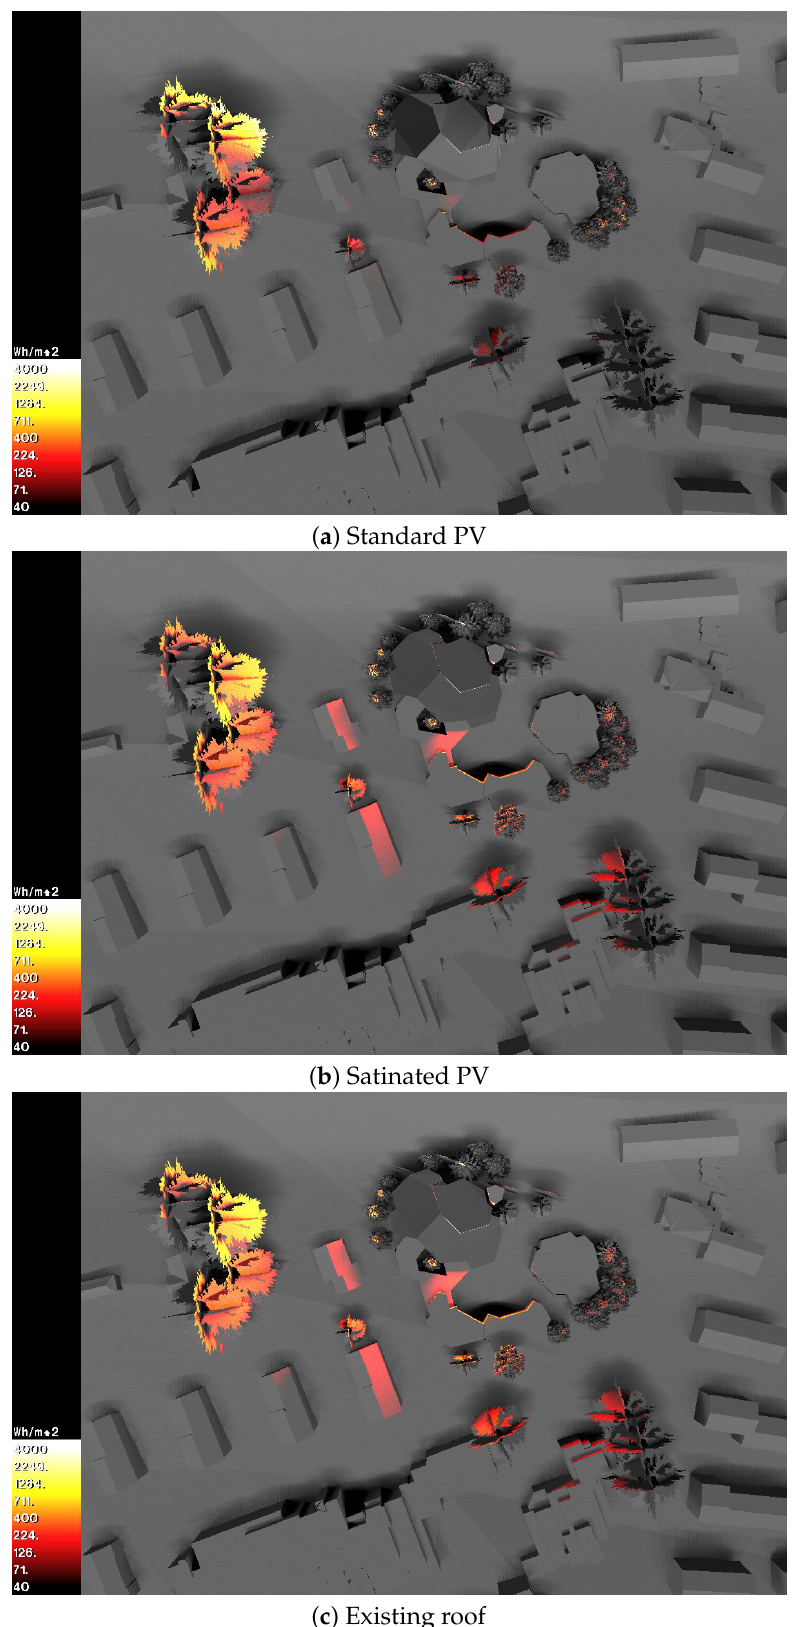
Figure 10. Plan views of absolute cumulative annual irradiance in Wh/m 2 from standard PV ( a ), satinated PV ( b ) and existing roof tile ( c